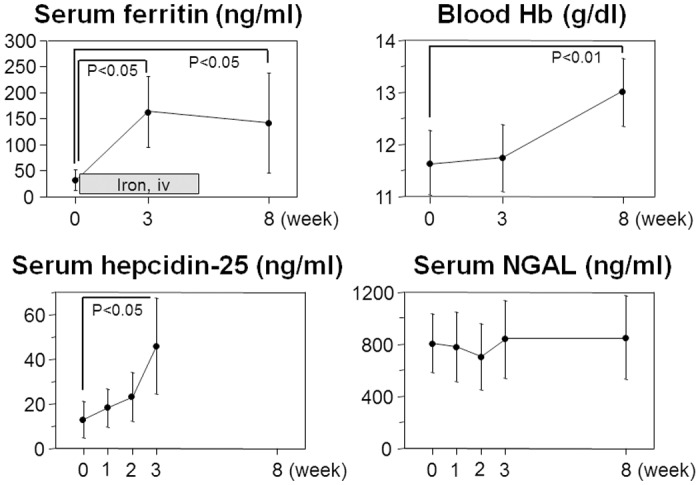
Effects of iron administration upon clinical parameters in maintenance HD patients.Mean±SD. Comparison between different time points was carried out by repeated-measures ANOVA with Dunnett post test. N = 6.